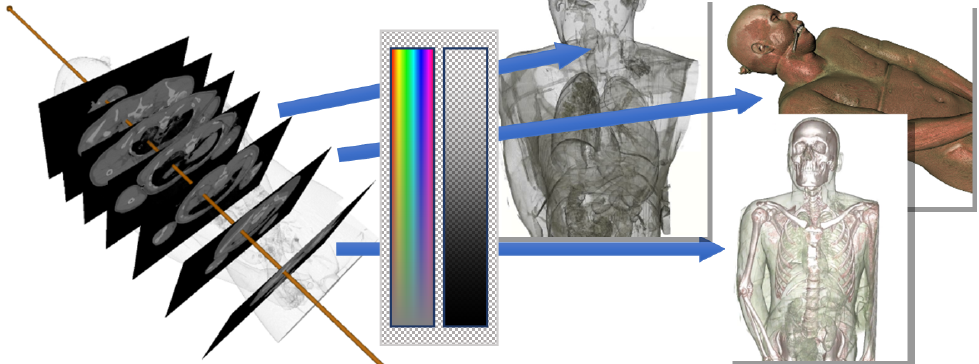
Figure 2. Generalized direct volume rendering (DVR) principle: The color values for single pixels of the output images on the right are computed by sampling the underlying dataset along view rays (arrow, left) and accumulating their individual visual contributions obtained by applying the transfer function assigning optical properties (color and transparency) to measurement values